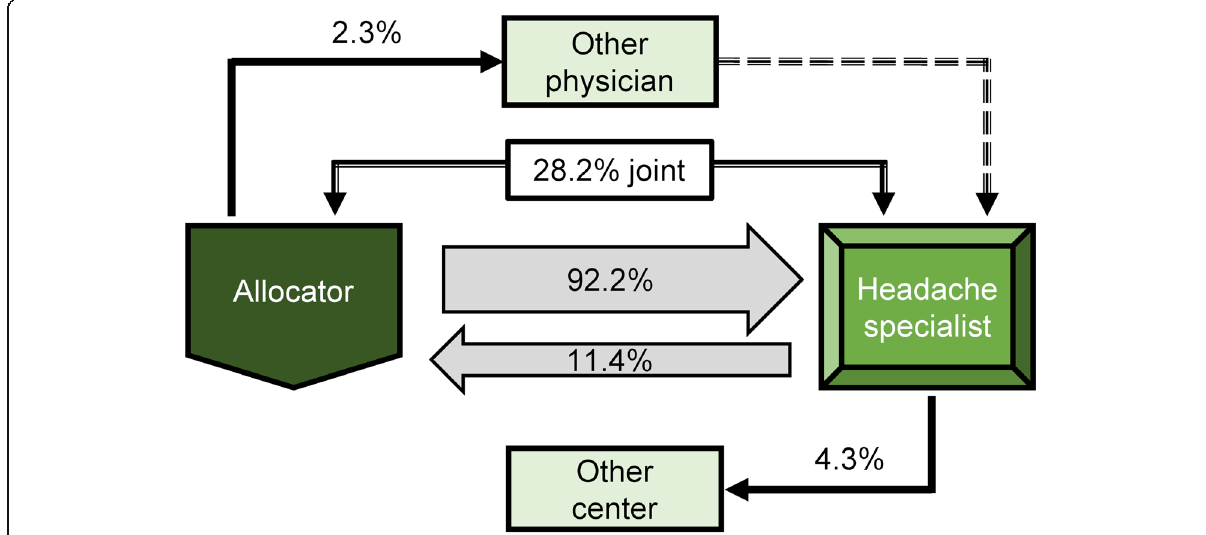
Fig. 1 Schematic overview of the referral structure of medical care for migraine patients